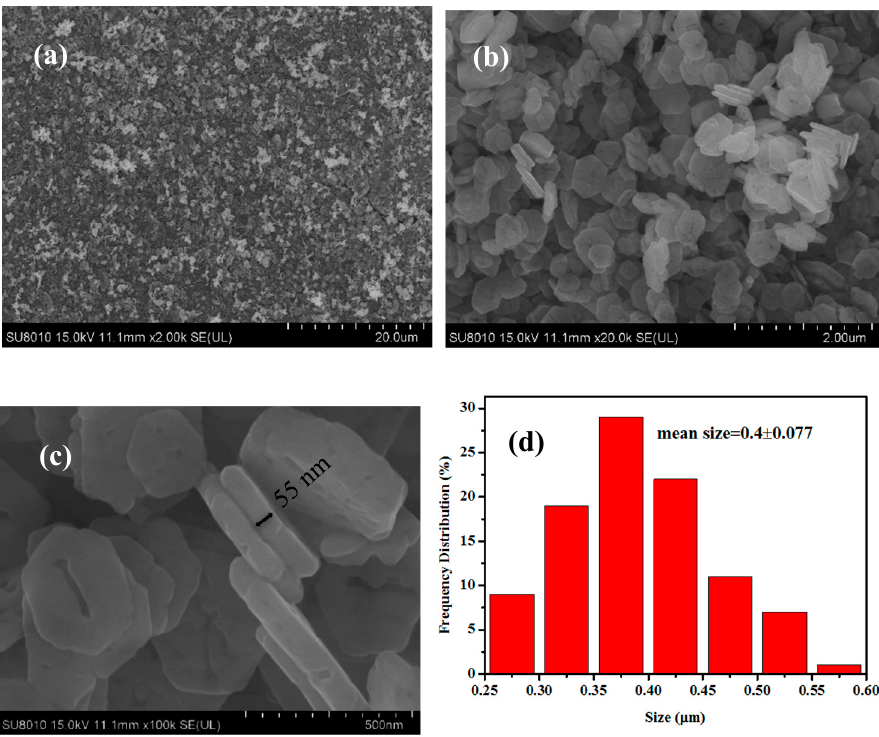
Figure 2. SEM images ( a – c ) and the size distribution ( d ) of the CuCo 2 O 4 nanoplatelets.